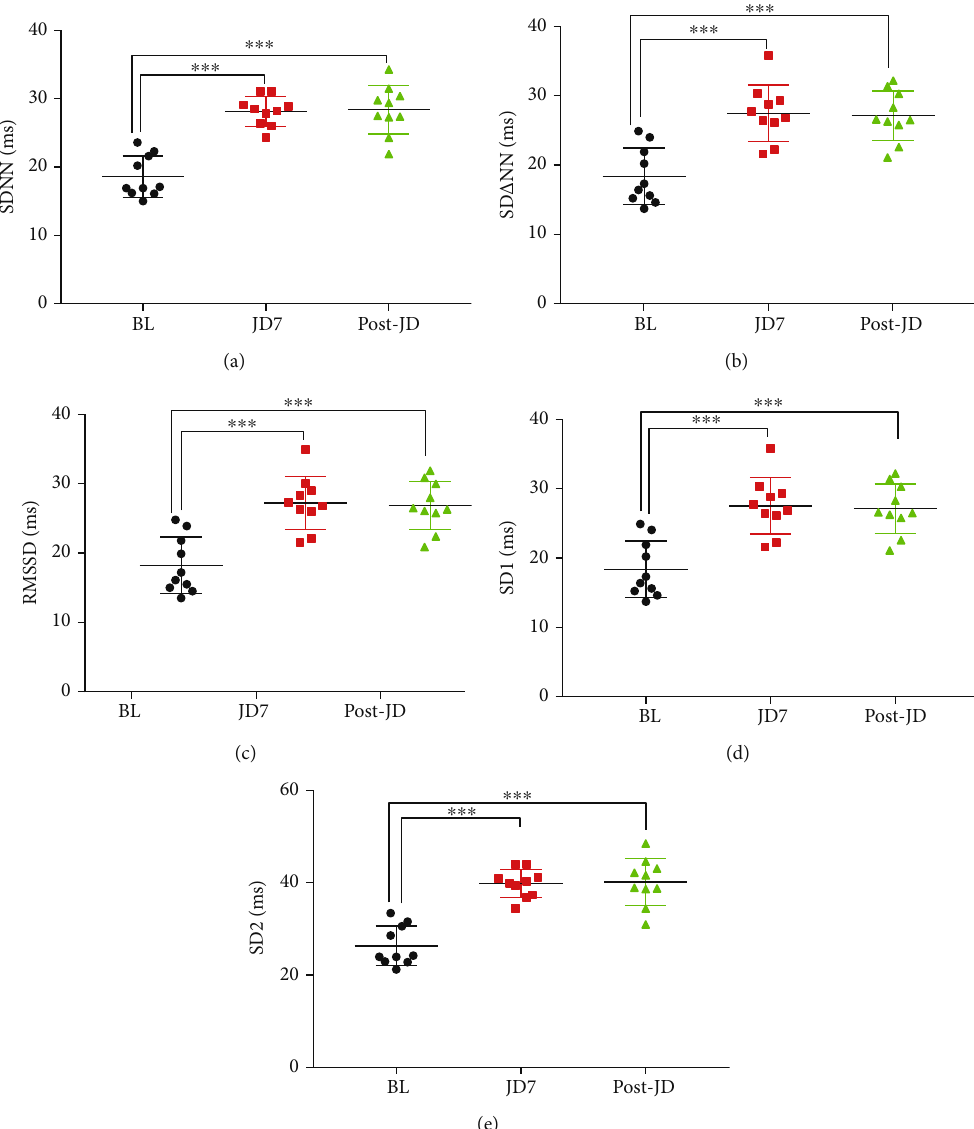
Figure 2: E ff ects of JD on the linear and Poincaré parameters of HRV. The e ff ects of jogging device (JD) on linear parameters of HRV; (a) standard deviation of all normal RR intervals (SDNN); (b) standard deviation of the delta of all RR intervals (SD Δ NN); (c) square root of the mean of the sum of the squares of di ff erences between adjacent NN intervals (RMSSD). The Poincaré parameters of HRV; the mathematical representation of the fi tted ellipse of the Poincaré plot. The width (SD1) (e) and length (SD2) of the ellipse (d) at baseline (BL), after seven days of JD (JD7), and seven days after completion of JD (Post-JD). ∗∗∗ p < 0 : 001 , BL vs. JD7 or